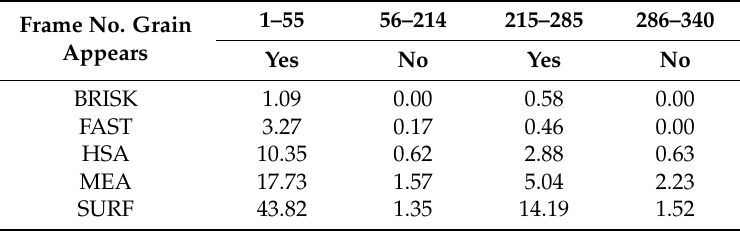
Table 1. The average values of the detected MIPs for all the frames (1–340) of the video material, classified according to the area of a grain occurrence and absence, for various methods.